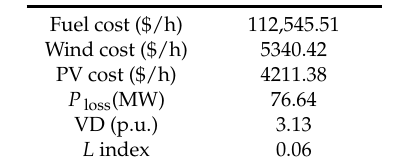
Table 17. Optimal solution of IEEE 118 bus power system for case study 12.